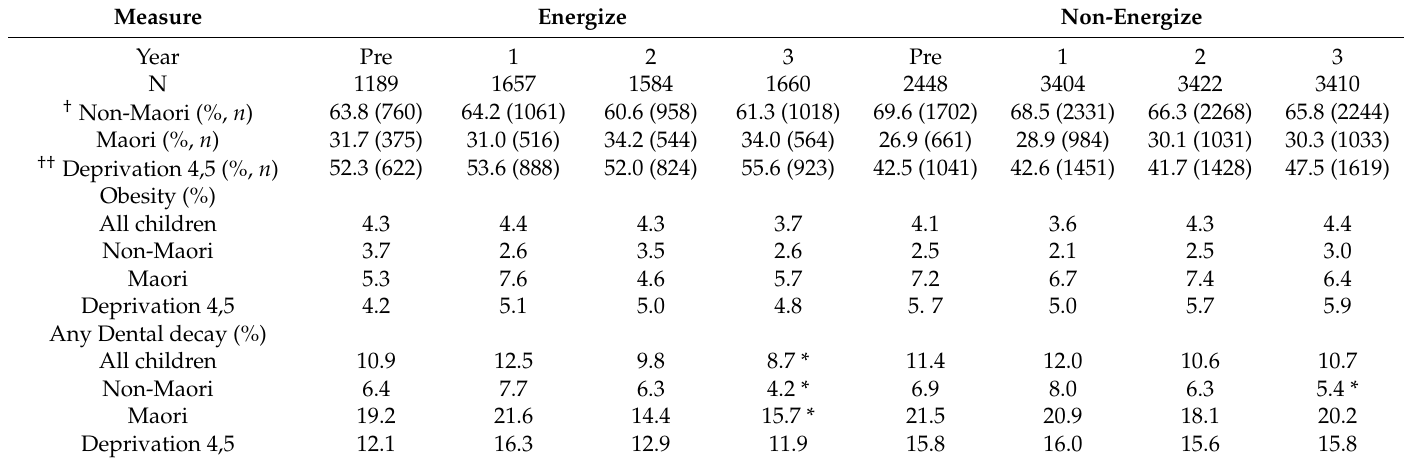
Table 3. Prevalence of obesity and prevalence of any progression to decay by stage and factor.